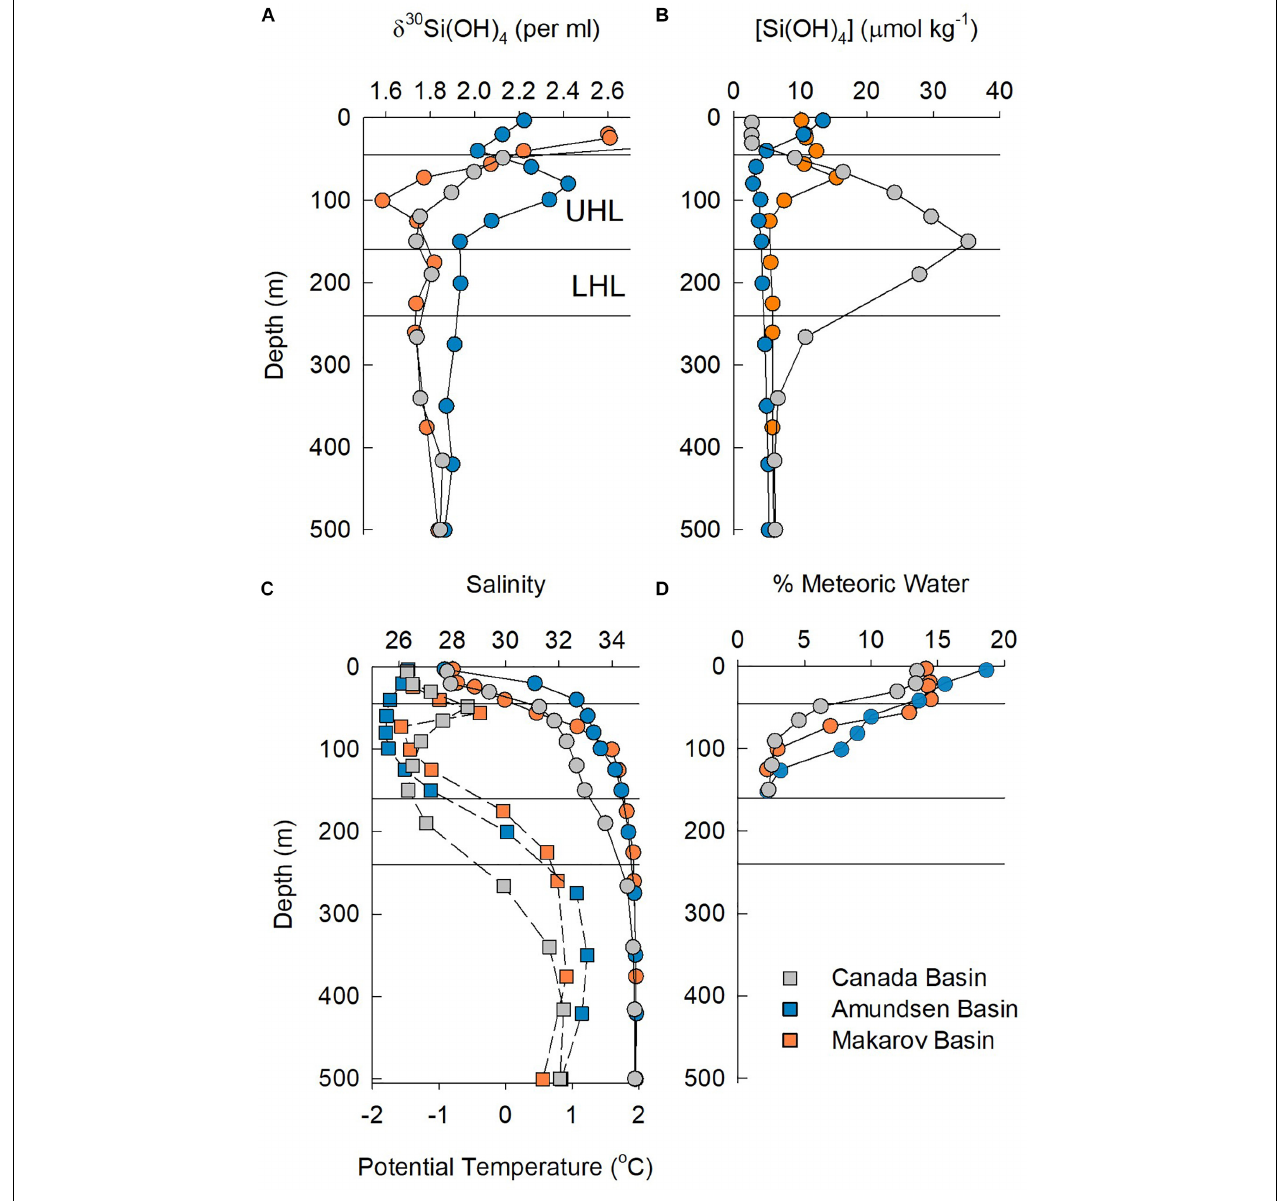
FIGURE 7 | Properties in the upper 500 m at station 48 in the Canada Basin, station 30 in the Makarov Basin, and station 32 in the Amundsen Basin. (A) Silicon isotope values, (B) silicic acid concentration, (C) salinity (squares) and potential temperature (circles), and (D) % meteoric waters. Horizontal lines denote the approximate boundaries of the UHL and